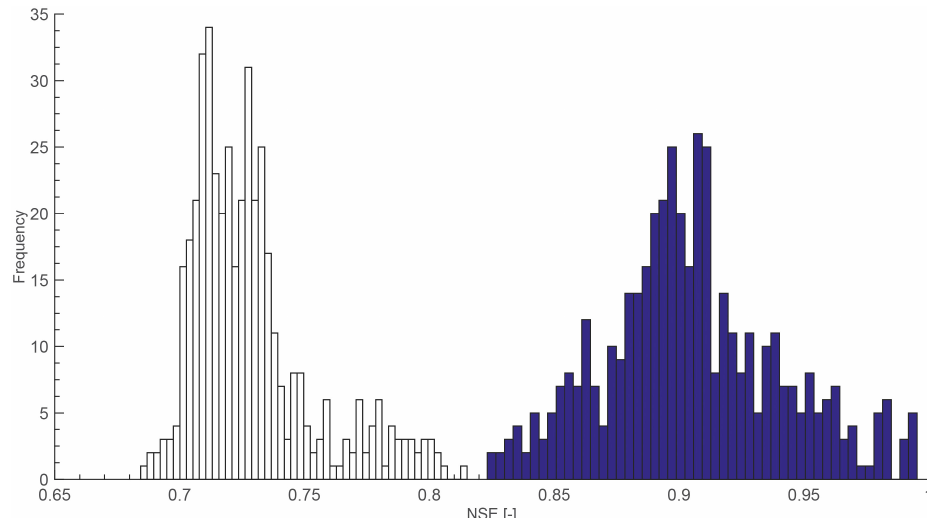
Figure 3. Histogram representing the reconstructed DWT (dark bins) and DCT (clear bins) NSE when compared to the observed rainfall signal. Rainfall is reconstructed after the input signal is compressed to 20 POP. Each frequency count represents a catchment from the MOPEX data set.